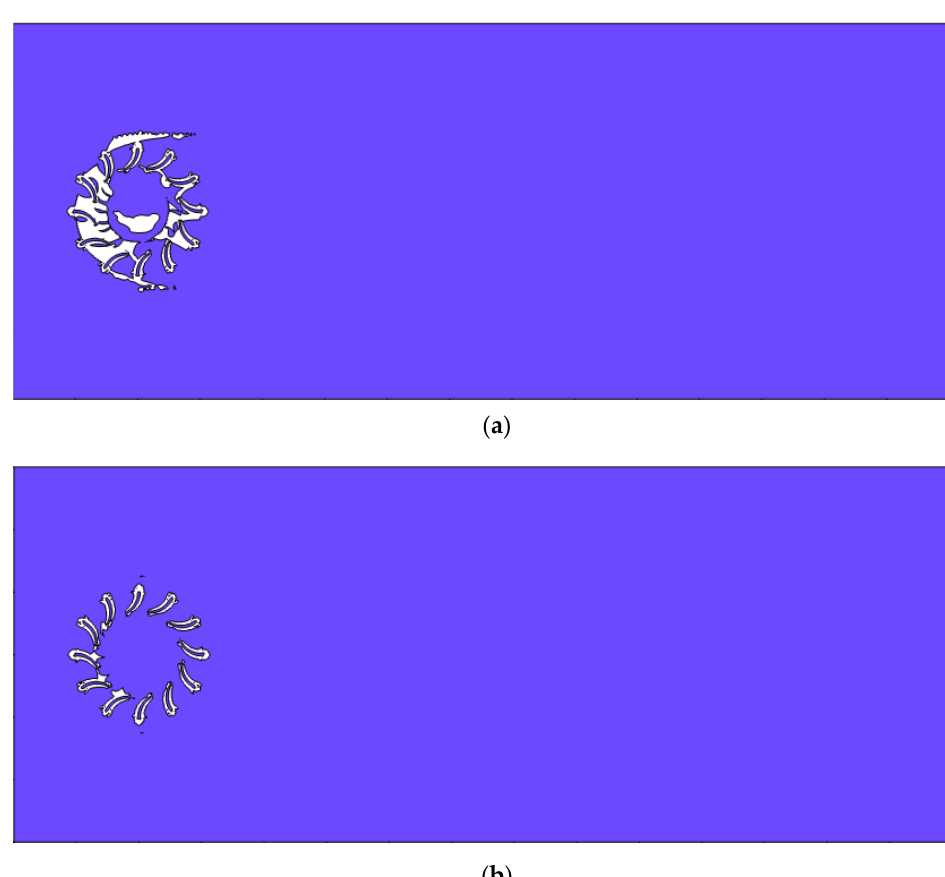
Figure 5. Spatial distribution of ∆ t within the flow domain: ( a ) lower limit = 0.005747, ( b ) lower limit = 0.0028735.